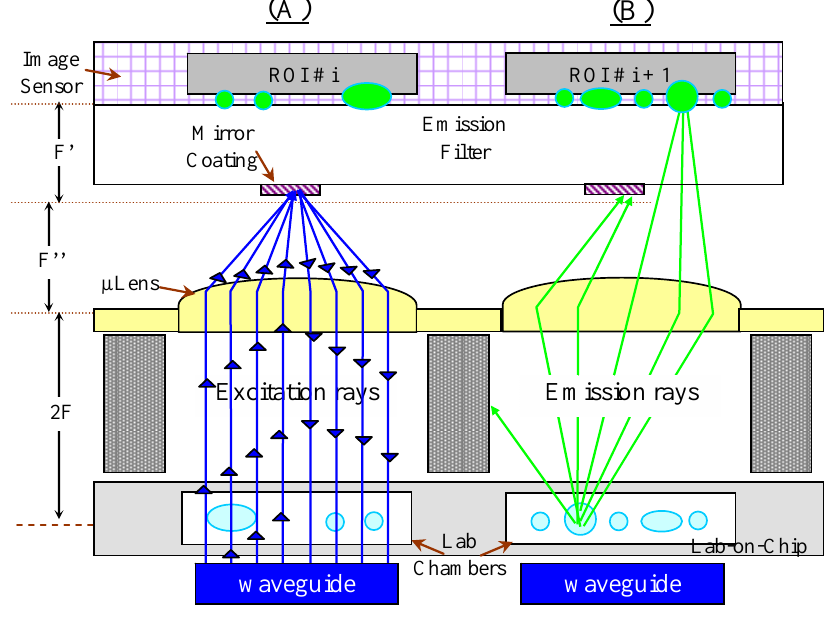
Figure 3. Excitation background spatial